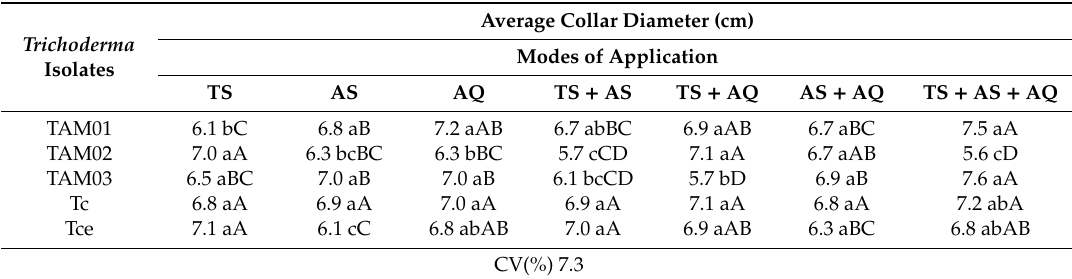
Table 5. Average collar diameter of Aça í ( Euterpe oleracea ) plants submitted to di ff erent modes of application of five isolates of Trichoderma spp. at 132 days after